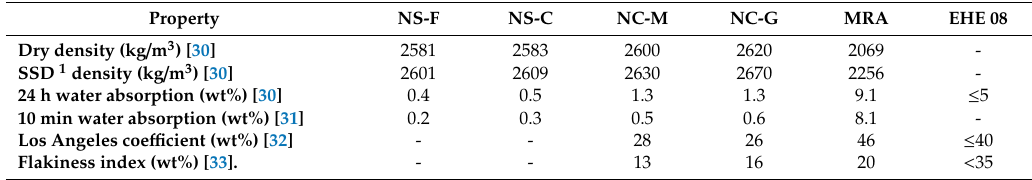
Table 4. Physical and mechanical properties of aggregates.